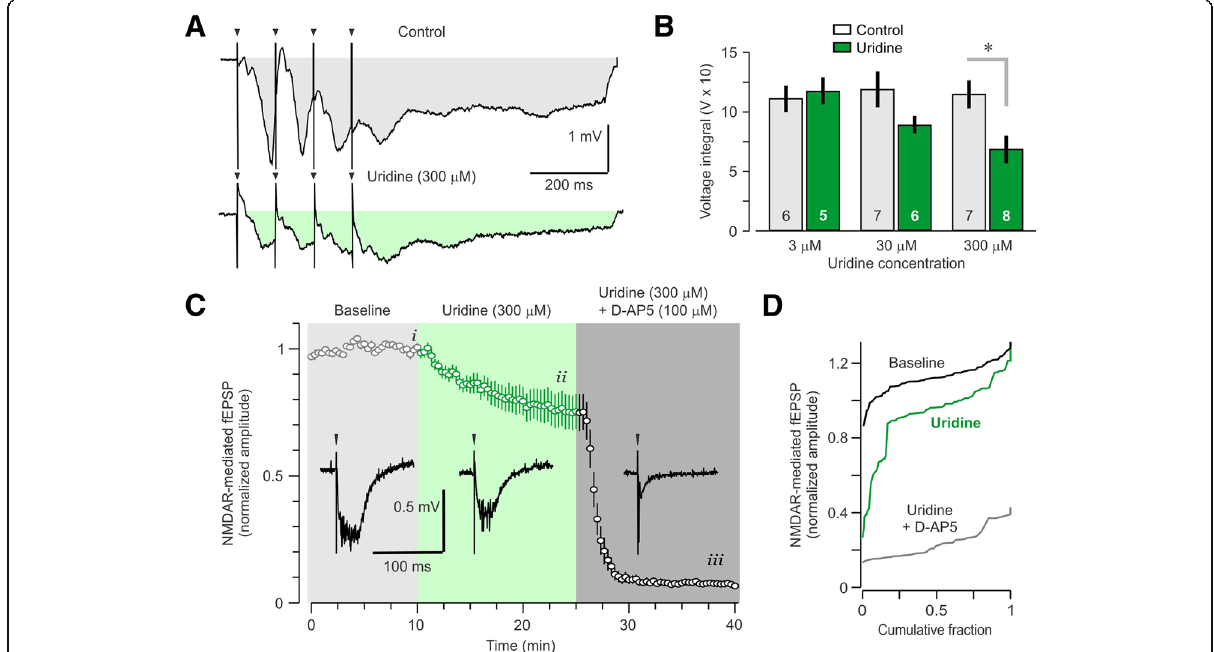
Fig. 4 Uridine decreases NMDAR-mediated synaptic responses. a Representative single theta-burst stimulation (TBS) event during LTP induction. Shaded areas indicate the total depolarization measured. b Mean total depolarization during TBS tetanus, which is highly mediated by NMDARs, is significantly lower in the presence of uridine (300 μ M); * P < 0.05 (MWU test). Numbers within bars indicate number of brain slices per group. c Plot shows mean fEPSP amplitudes of pharmacologically isolated NMDAR-mediated fEPSPs in several conditions: ( i ) baseline, no uridine ( ii ) uridine (300 μ M), and ( iii ) uridine (300 μ M) + D-AP5 (100 μ M). Accompanying sample traces from each condition are shown in the insets. d Cumulative probability plots show that uridine (300 μ M) significantly decrease NMDAR – mediated fEPSPs amplitudes, which are essentially eliminated in the presence of the NMDAR antagonist